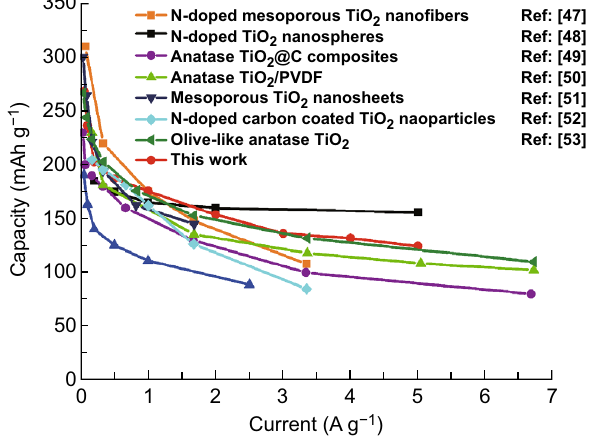
Fig. 4 Comparison of rate capability of TiO 2 /N–C NFs with that of previously with various